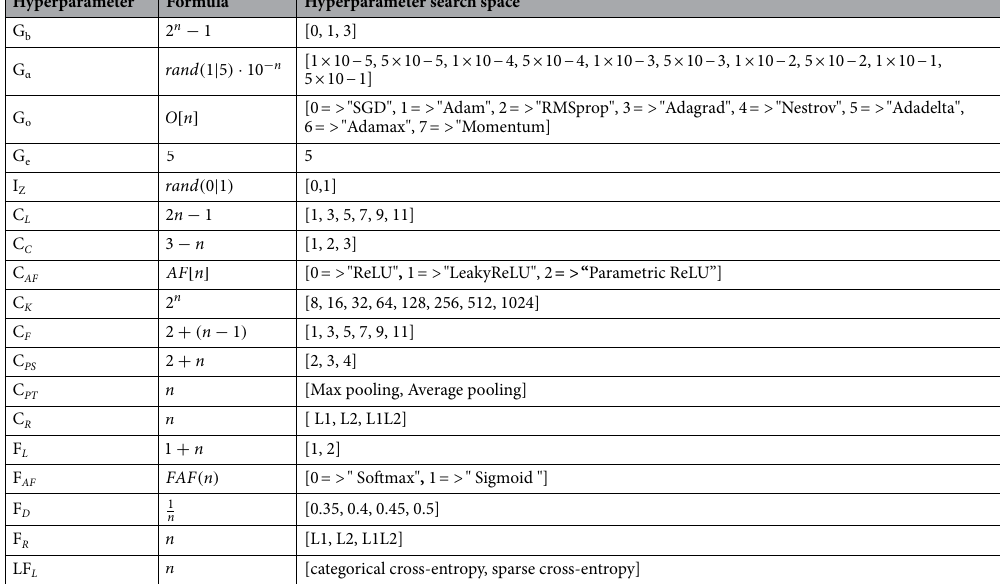
[categorical cross-entropy, sparse cross-entropy] Table 4. A summary of formula for computing values for hyperparameters and the corresponding search space using the proposed encoding scheme.